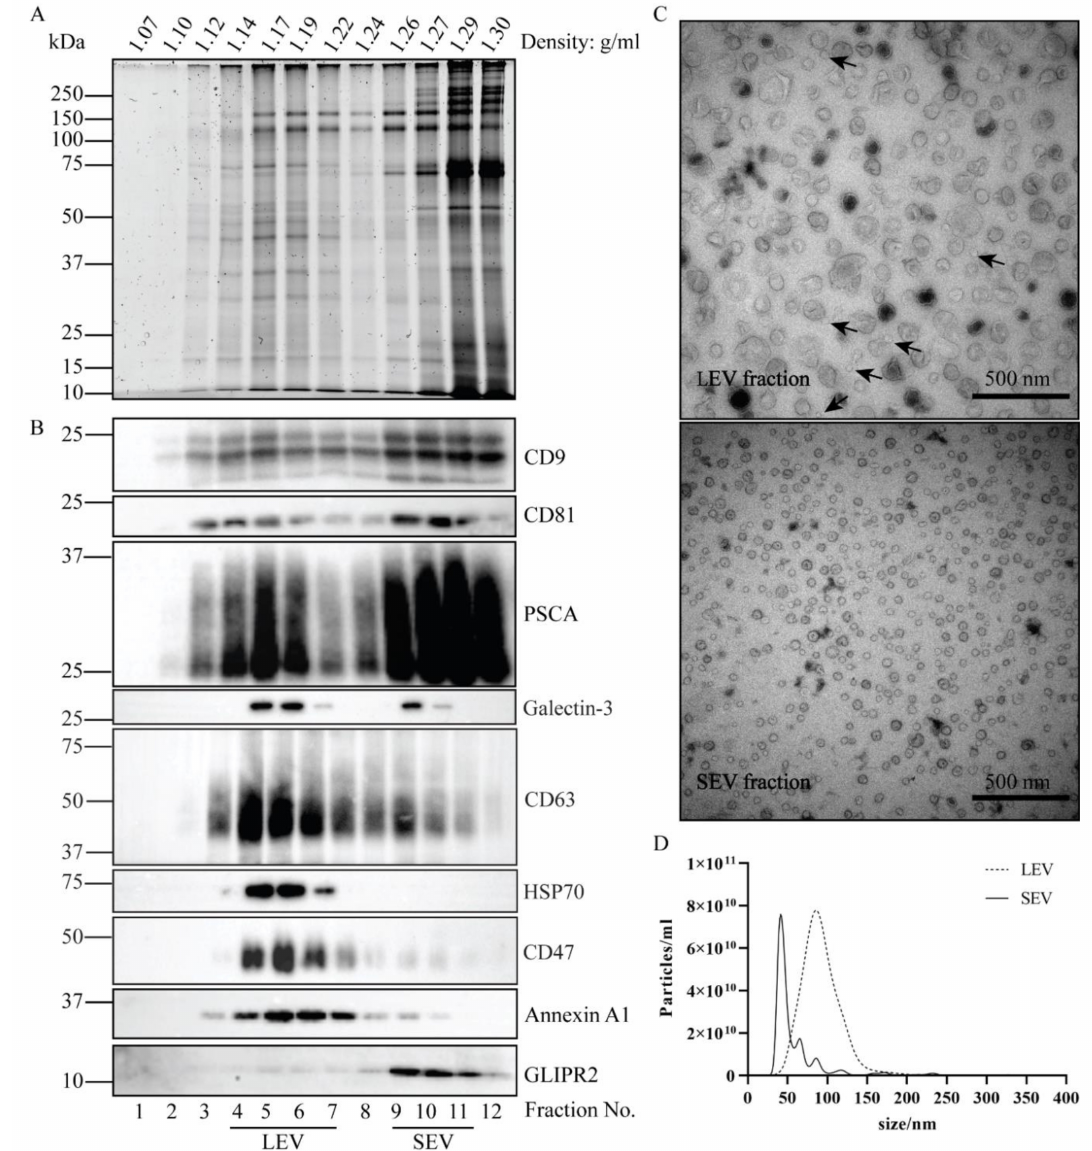
Figure 1. Isolation and characterization of LEV and SEV. Total EV in seminal plasma of vasectomized men were collected by UC at the interface of a sucrose block gradient. LEV and SEV were separated by their distinct velocities during upward displacement into a continuous sucrose density gradient. ( A ) Gradient fractions were analyzed by SDS-PAGE followed by Sypro ruby staining for total protein. ( B ) Gradient fractions were analyzed by immunoblotting for the presence of EV associated proteins, including CD9, CD81, PSCA, Galectin-3, CD63, HSP70, Annexin A1, and GLIPR2. Molecular weight markers are indicated on the left in kDa. ( C ) Particles in the LEV and SEV containing fractions were analyzed by TEM. Scale bar, 500 nm. Arrows exemplify incidental SEV in the LEV isolate. ( D ) Size distribution of the particles in LEV and SEV isolates as determined by